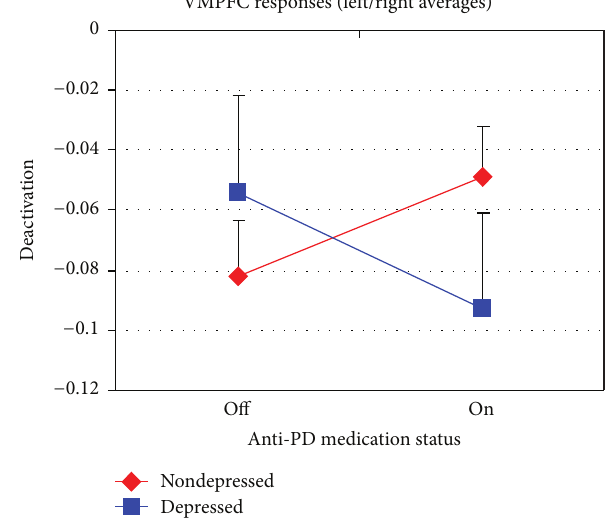
Figure 2: Dopaminergic medication by depression interaction in the ventromedial prefrontal cortex (VMPFC) in PD patients; data points depict the average value across emotion categories from the 4th column of Table 2. Error bars represent the standard error of the